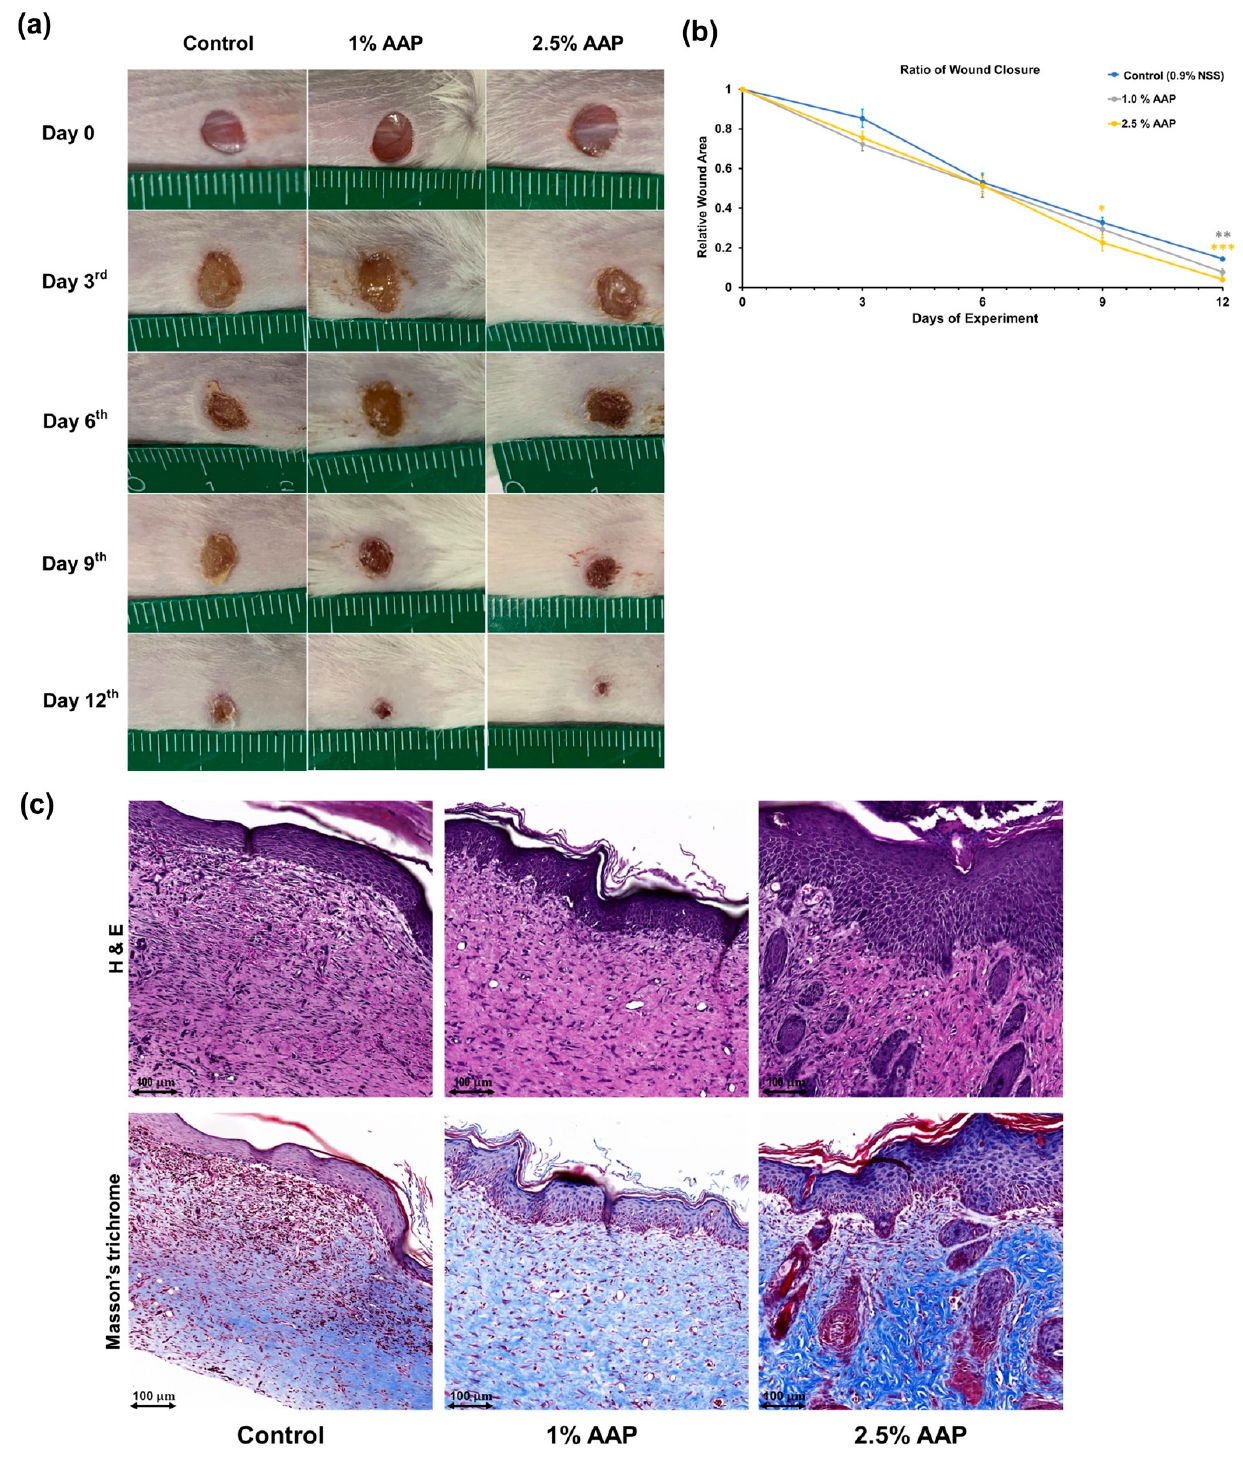
Figure 6. AAP accelerated wound closure and wound healing in vivo. ( a ) Photographs of the full thickness excision wounds in BALB/C mice in each group on day 0, 3, 6, 9, and 12 of the experiment. ( b ) The ratio of wound closure was expressed as relative wound area compared with that which was present on each day of the experiment. ( c ) H&E ( upper panel ) and Masson’s Trichrome (lower panel) stained wound tissues after 12 days of treatment with 0.9% sterilized normal saline solution (left), 1% w / v AAP (middle), and 2.5% w / v AAP (right). Data are expressed as Mean ± SE values, n = 7 for each group. * p < 0.05, ** p < 0.01, and *** p < 0.001 vs. vehicle control